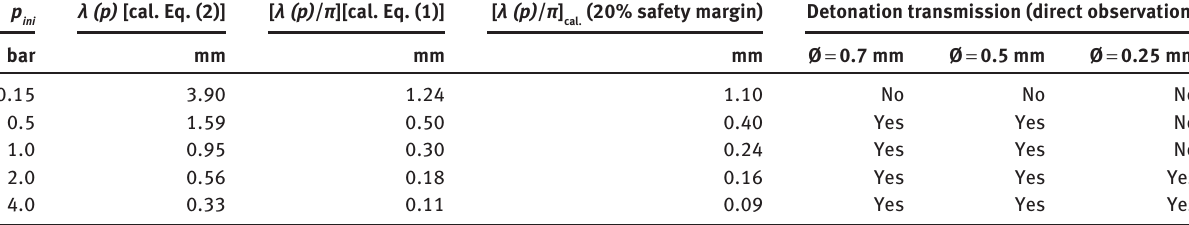
Table 3 Comparison of safe capillary diameters for stoichiometric (equivalence ratio = 1) ethane/oxygen mixtures calculated by Eqs. (1) and (2) with direct